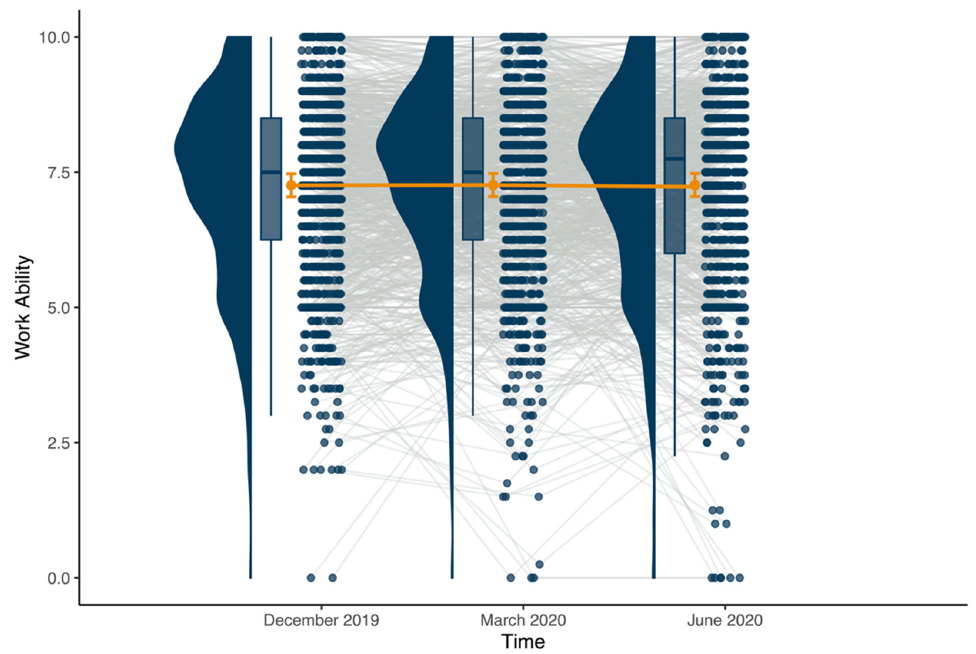
Figure 1. Between- and Within-Person Variability in Work Ability from T1 (December 2019) to T3 (June 2020). Note: Connected orange points and associated 95% confidence intervals represent between-person relationships; connected blue points represent within-person relationships.